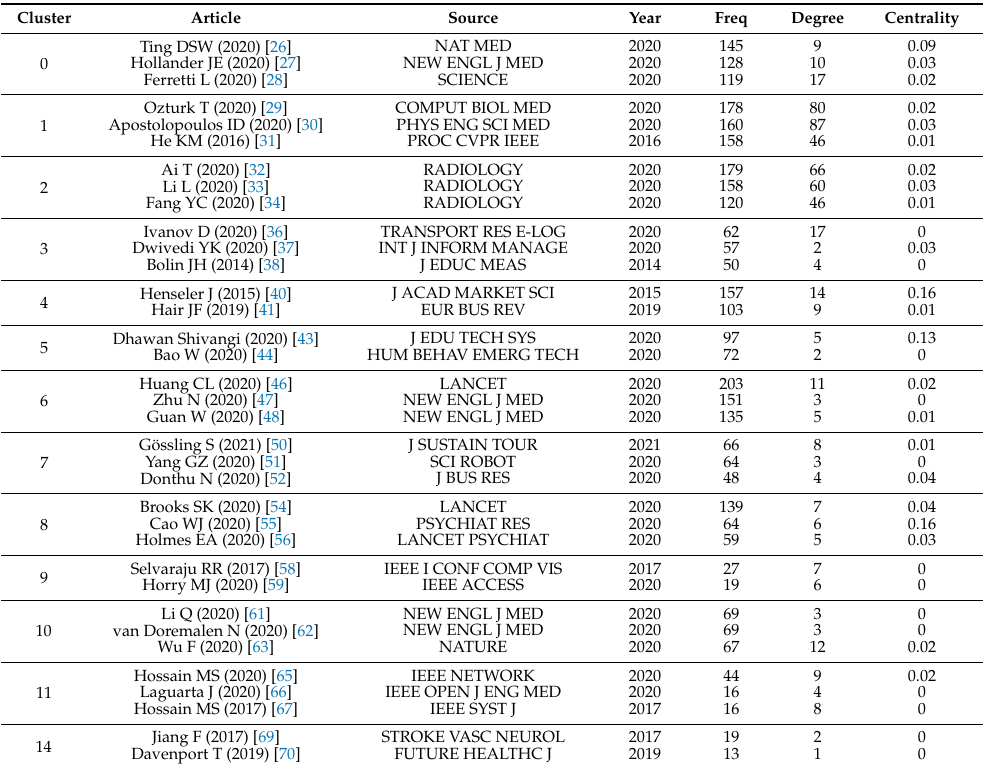
Table 8. Representative articles from the literature co-citation